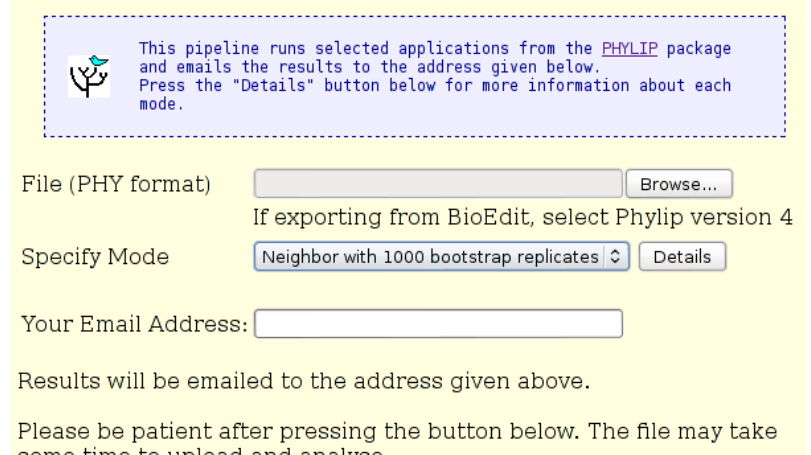
Figure 8. The “Pipeline: TreeMail” input page. An input file in “Phylip” format is required.